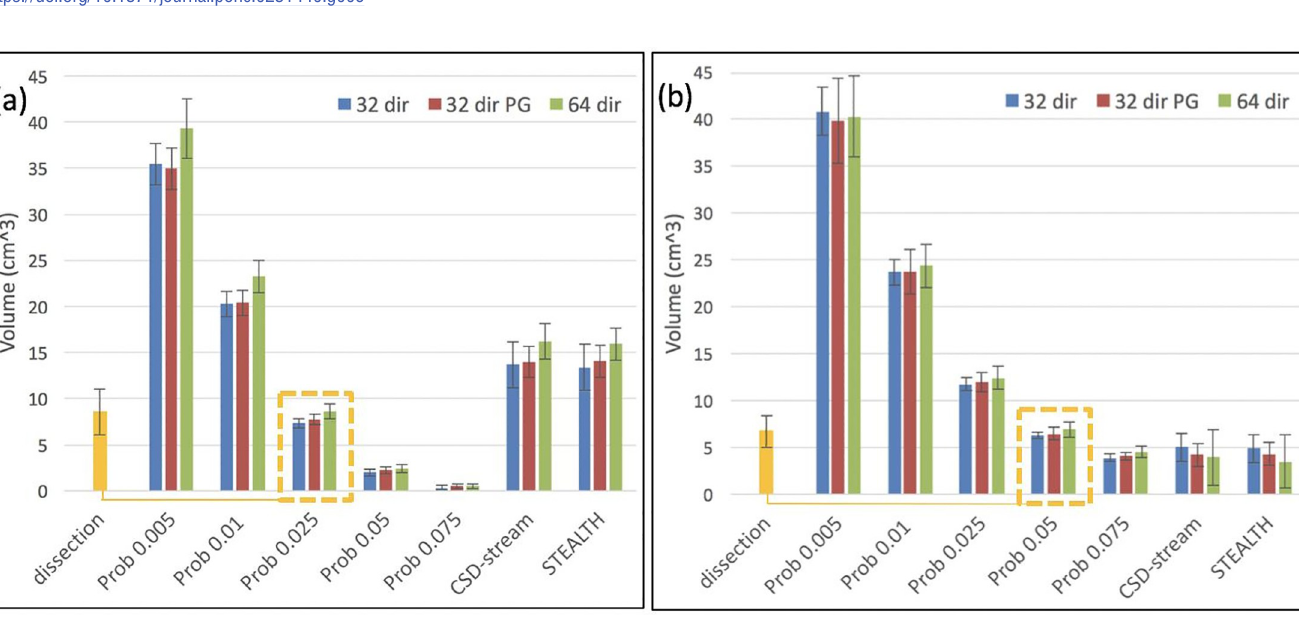
Fig 7. Tract volumes across 10 volunteer subjects for (a) the CST compared to dissection studies of [24] and (b) the OR compared to the dissection studies of [23]. Error bars depict the standard deviation in volume. The yellow dashed boxes highlight that Prob 0.025 and Prob 0.05 best match the results from dissections studies for the CST and OR,